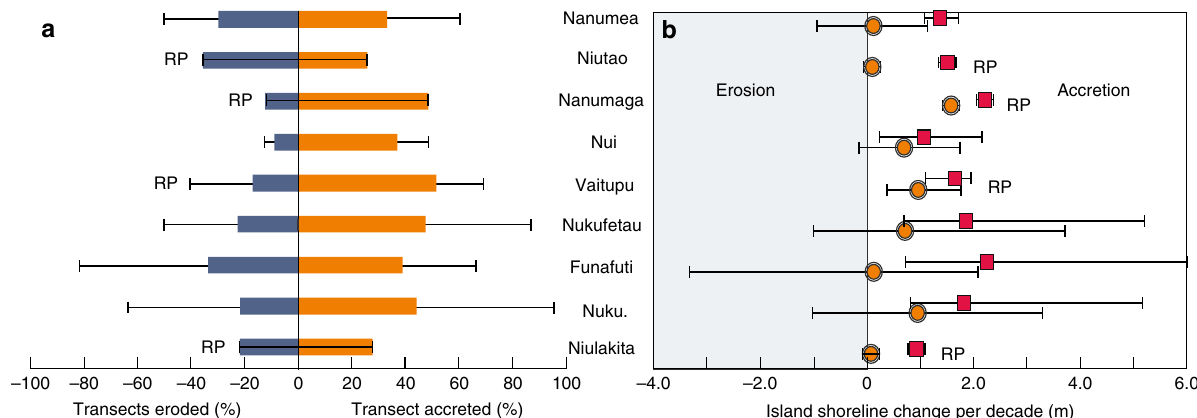
Fig. 2 Summary changes in shoreline dynamics between atolls based on Digital Shoreline Analysis System analysis of island shoreline transects. a Percentage of shoreline transects experiencing erosion (blue bars) and accretion (orange bars) aggregated at the atoll scale, error bars represent maximum transect erosion and accretion in each atoll. b Net rate (orange circles) and gross rate (red squares) of shoreline movement per decade aggregated at the atoll scale. Error bars represent minimum and maximum rates within each atoll. Source data: Supplementary Data 2